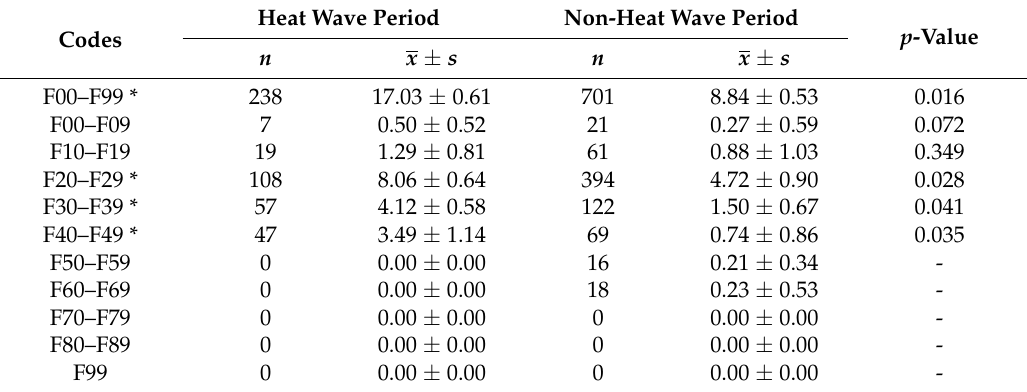
Table 4. Description of daily hospitalized cases during the study period according to ICD-10.